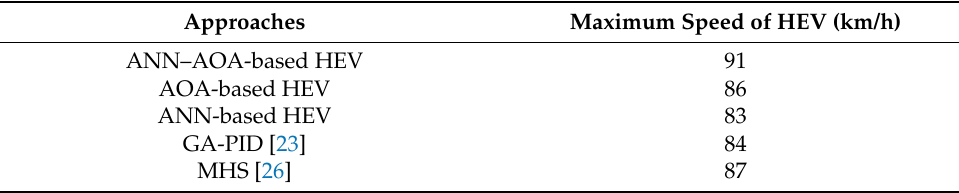
Table 3. Evaluation of vehicle speed under various methodologies.